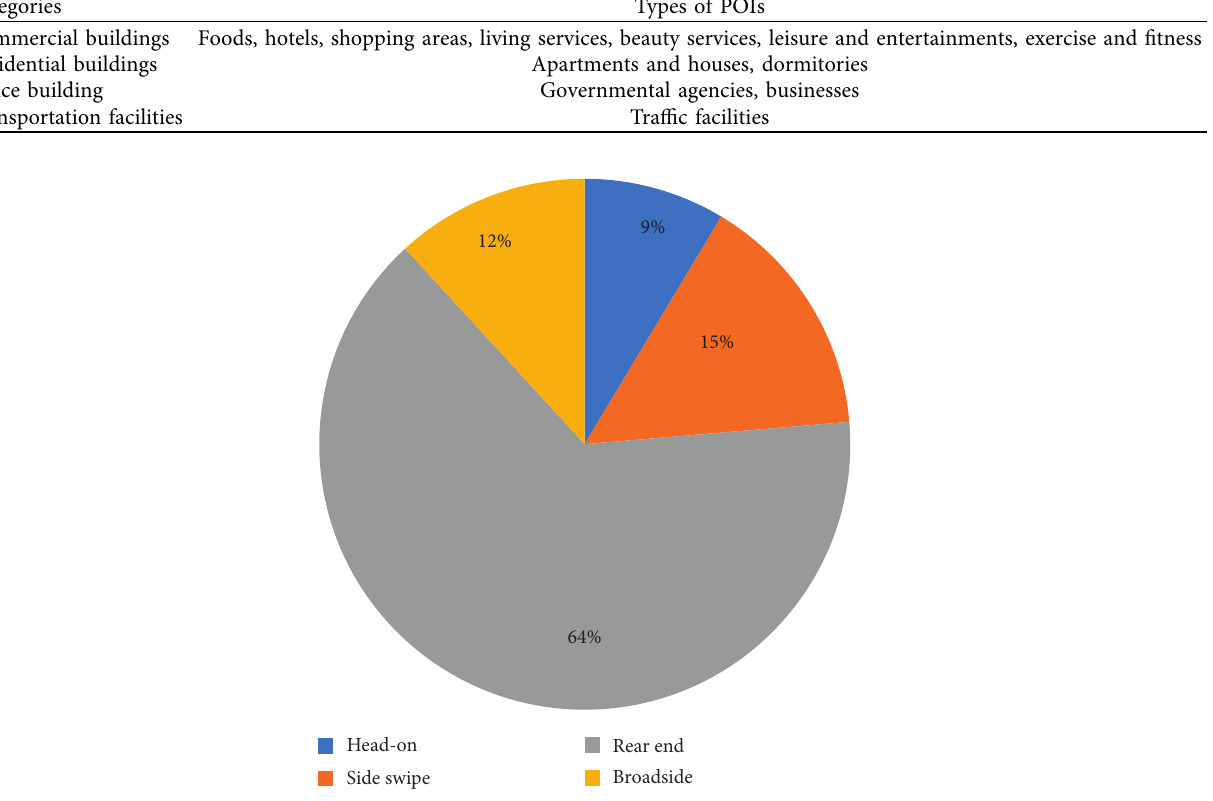
Figure 1: The distribution of collision type.